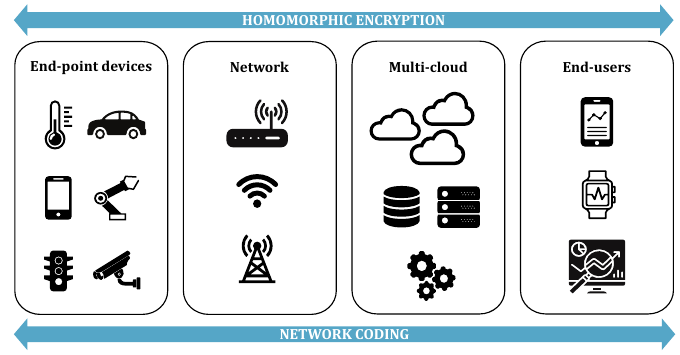
Figure 1. Network coding and homomorphic encryption over IoT